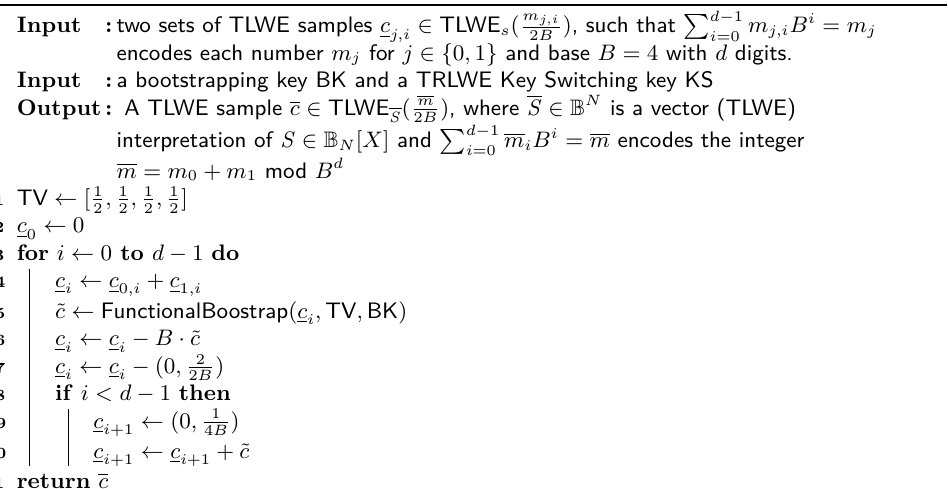
Algorithm 12: Addition algorithm using the chaining